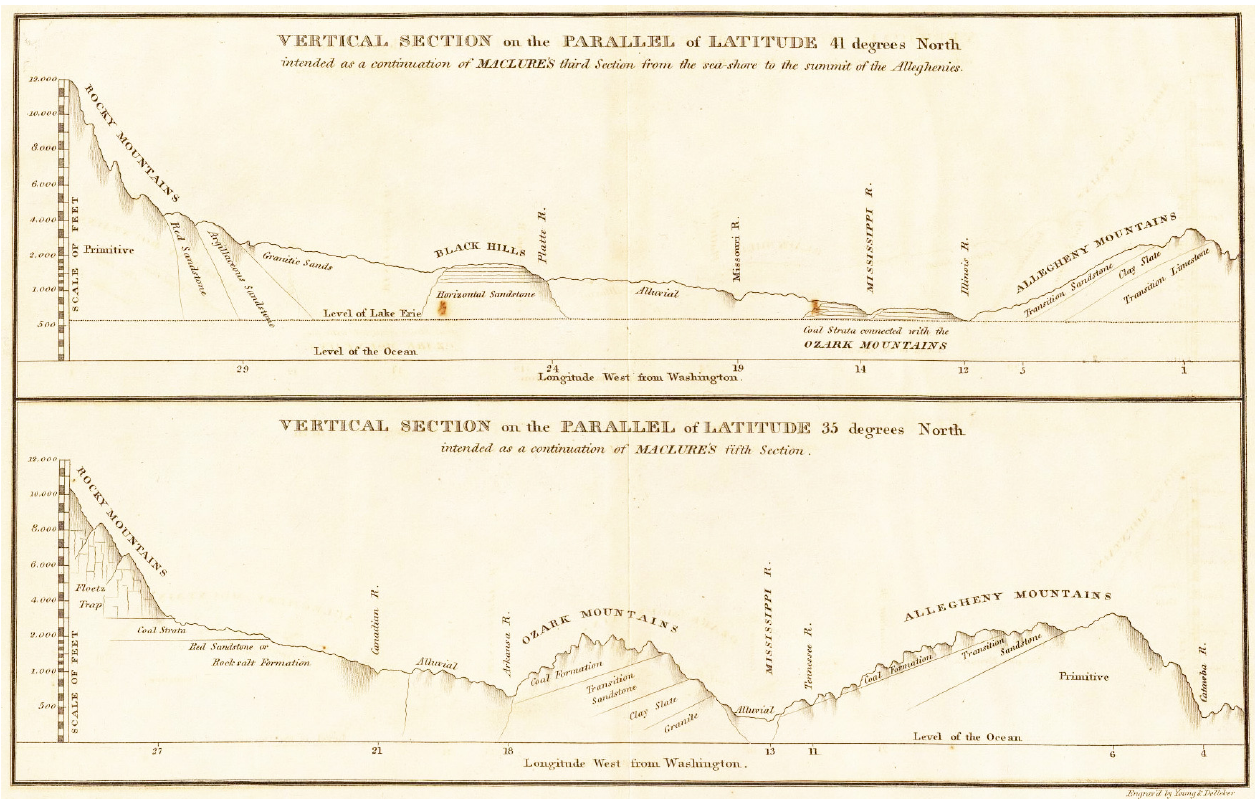
Figure 5. Vertical sections depicting James’ extensions of Maclure’s geology westward (James, 1823). James (1822b, p. 326) advised that the horizontal scale is inaccurate and that “the inclination indicated by the lines between the formations is not to be considered applicable to all the strata constituting those formations.”